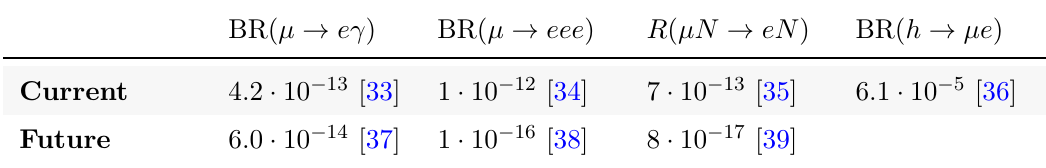
Table 1 . Current and near future upper bounds on ∆ L e = ∆ L µ = 1